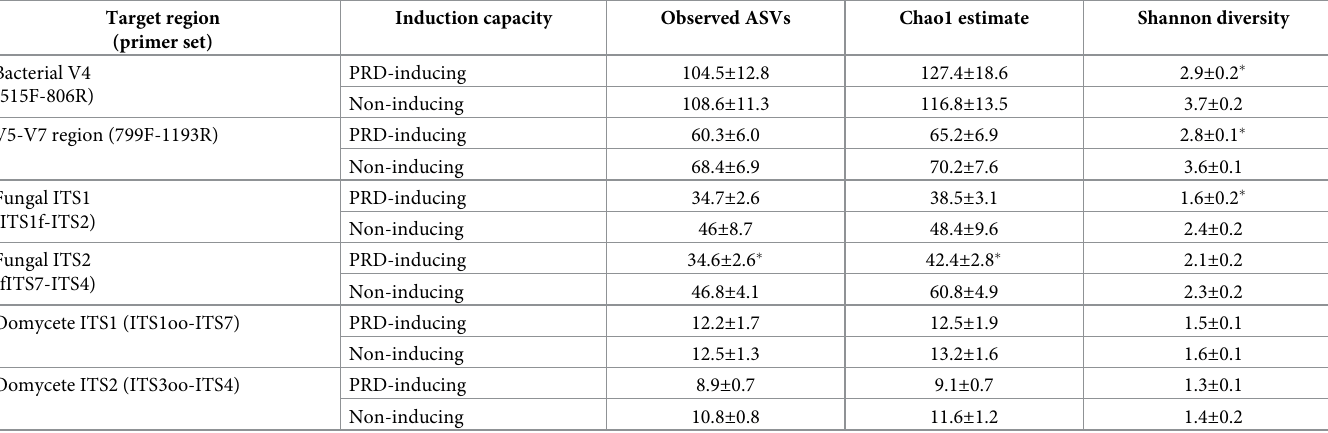
Table 3. Diversity indices among bacterial, fungal, and oomycete root microbial communities as a function of soil PRD-inducing capacity a . Target region (primer set)